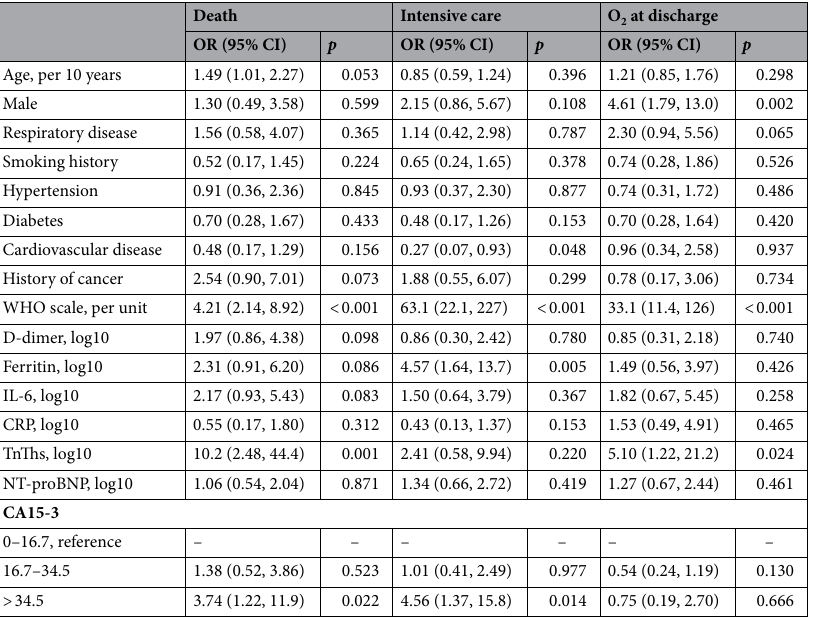
Table 3. Multivariable adjusted analysis of predictors at baseline of complications during in-hospital evolution of patients with